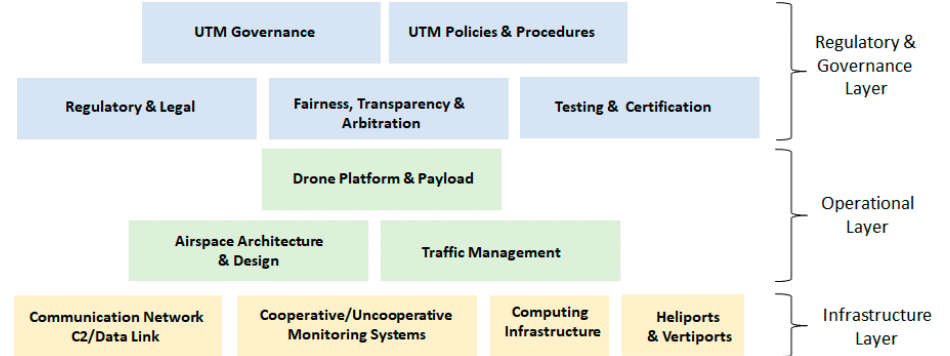
Figure 2. Conceptual overview of an Urban UTM comprising three layers: foundational; operational; regulatory and governance.